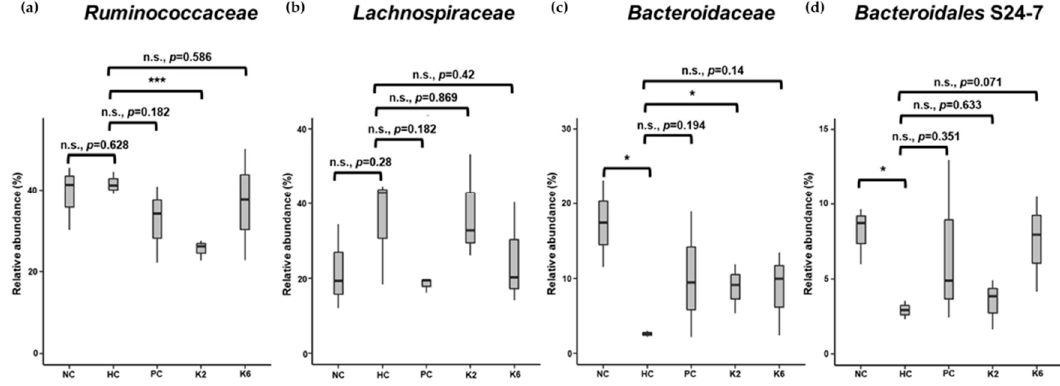
Figure 10. Relative abundance of family ( a ) Ruminococcaceae , ( b ) Lachnospiraceae , ( c ) Bacteroidaceae , and ( d ) Bacteroidales S24-7 in each group. Each box plot represents results of three pooled fecal samples. NC, normal diet control; HC, HF / HF diet control; PC, HF / HF diet with silymarin; K2, HF / HF diet with ATG-K2; K6, HF / HF diet with ATG-K6. * p < 0.05, *** p < 0.005, n.s., not significant versus the HC group. Student’s t-test was used to compare the group means.